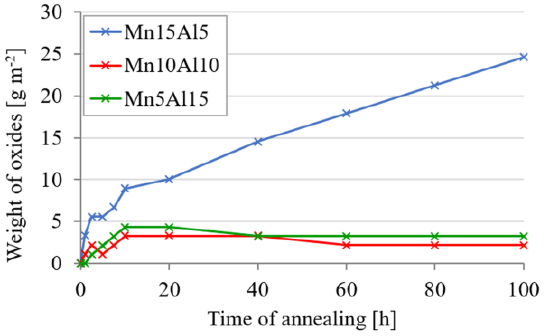
Figure 14. Weight increment of oxides during annealing at 800 °C for 100 h. (Error bars represent confidence intervals).